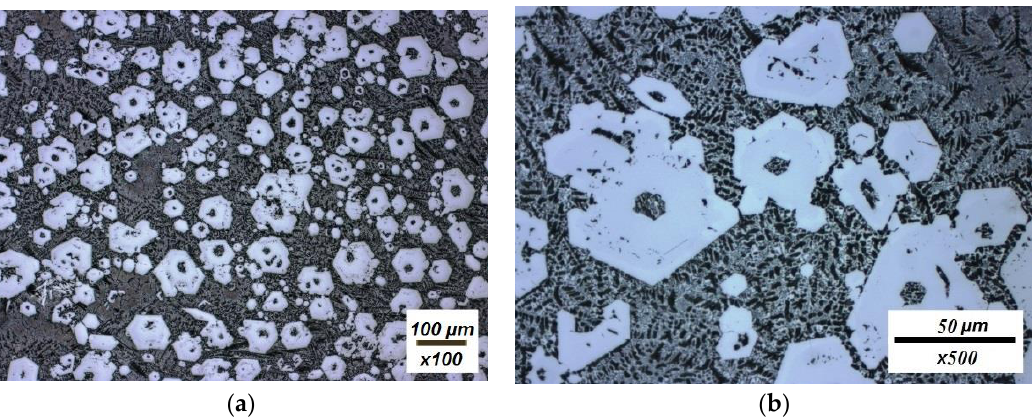
Figure 5. Microstructure of master alloy 25Mg–50Zn–25Nd. Zoom ( a ) ×100, and ( b ) ×500. MicroX-ray spectralanalysis ofthe structure sectionsshows (Figure6a) thatindividual intermetallic compounds contain about 21 wt.% neodymium, which corresponds to the Mg 3,4 NdZn 7 phase. Double eutectic (Figure 6b), alloyed with neodymium, contains 32.41 wt.% magnesium, 60.72 wt.% zinc and 6.88 wt.% neodymium (Table 4).